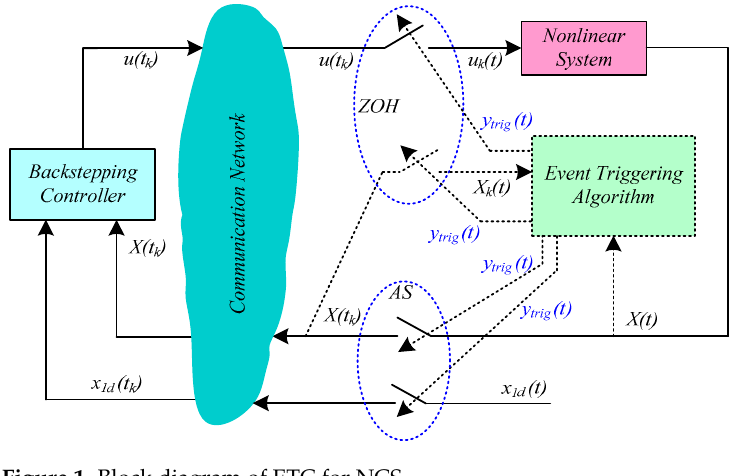
Figure 1. Block diagram of ETC for NCS.